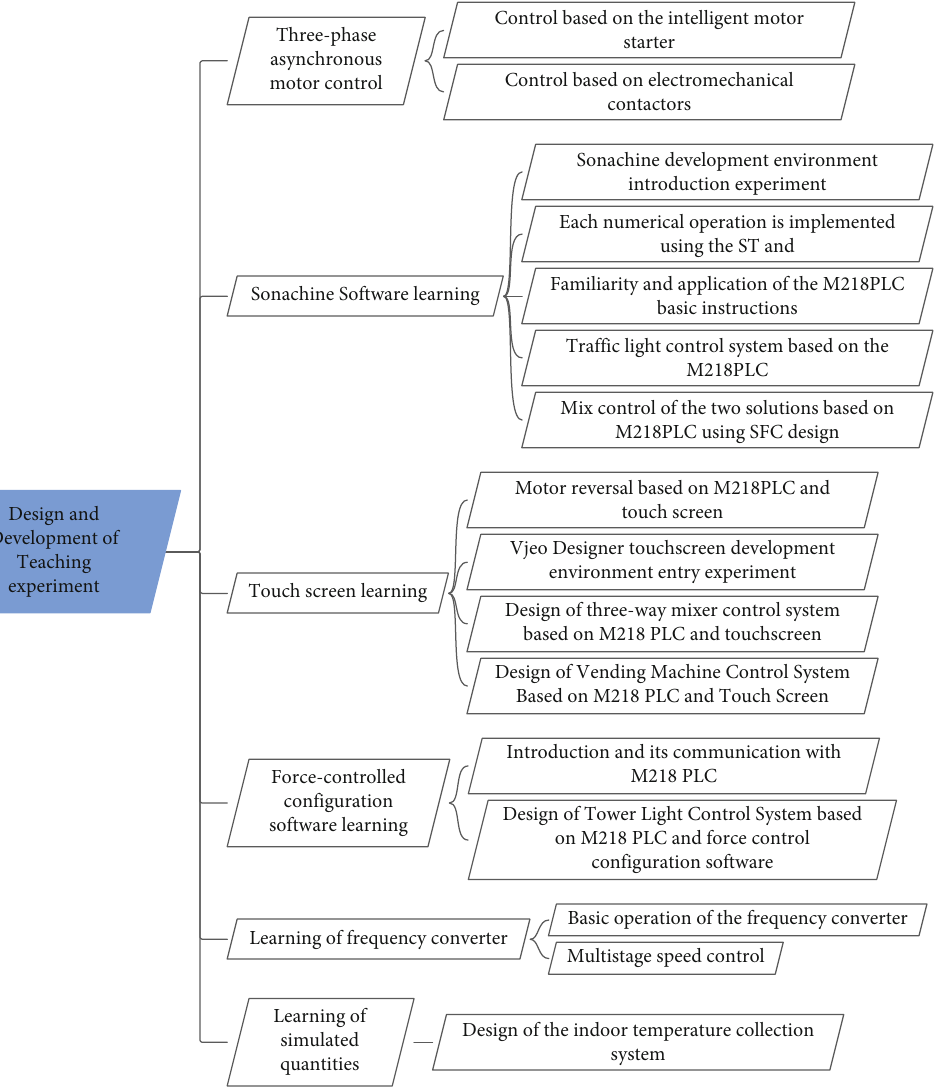
Figure 10: Diagram of teaching experiment